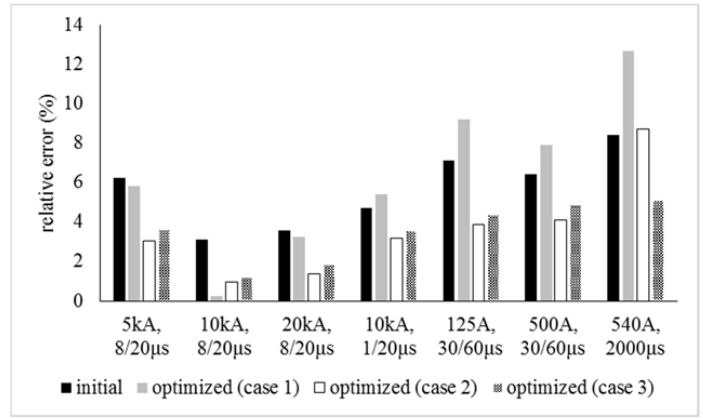
Table 1. Characteristics of the arrester under study.